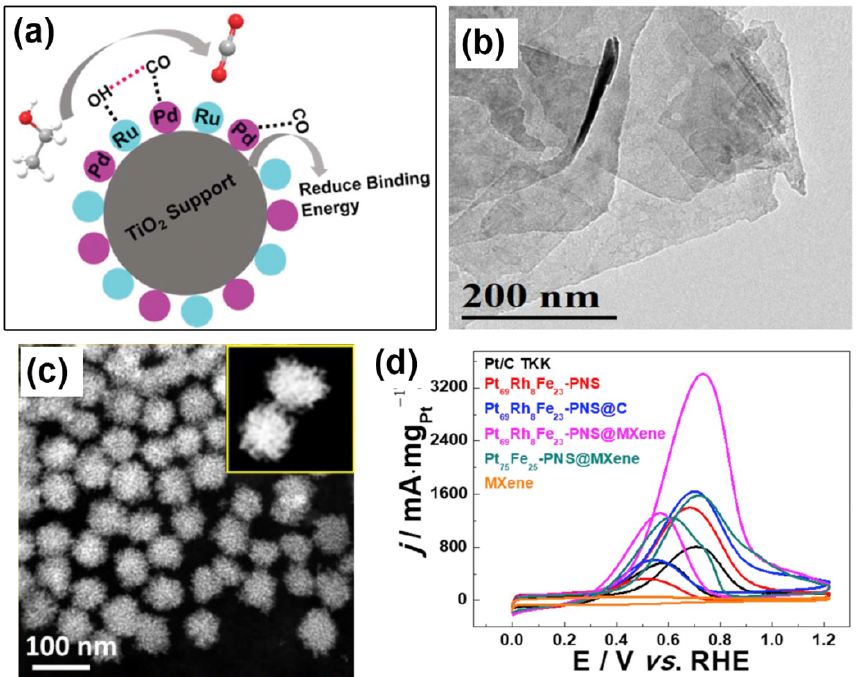
Figure 6. ( a ) The schematic diagram of the synergistic effects between Ru and TiO 2 . Reproduced with permission from [32] . Copyright 2019, Royal Society of Chemistry. ( b ) TEM image of the isolated Ti 3 C 2 T x MXene nanosheets. ( c ) HAADF-STEM image of hybrid PtRhFe-NPS@MXene catalysts. ( d ) Cyclic voltammogram curves of as-prepared catalysts in N 2 -saturated with 1.0 M ethanol solution. Reproduced with permission from [28] . Copyright 2019, Elsevier Ltd.